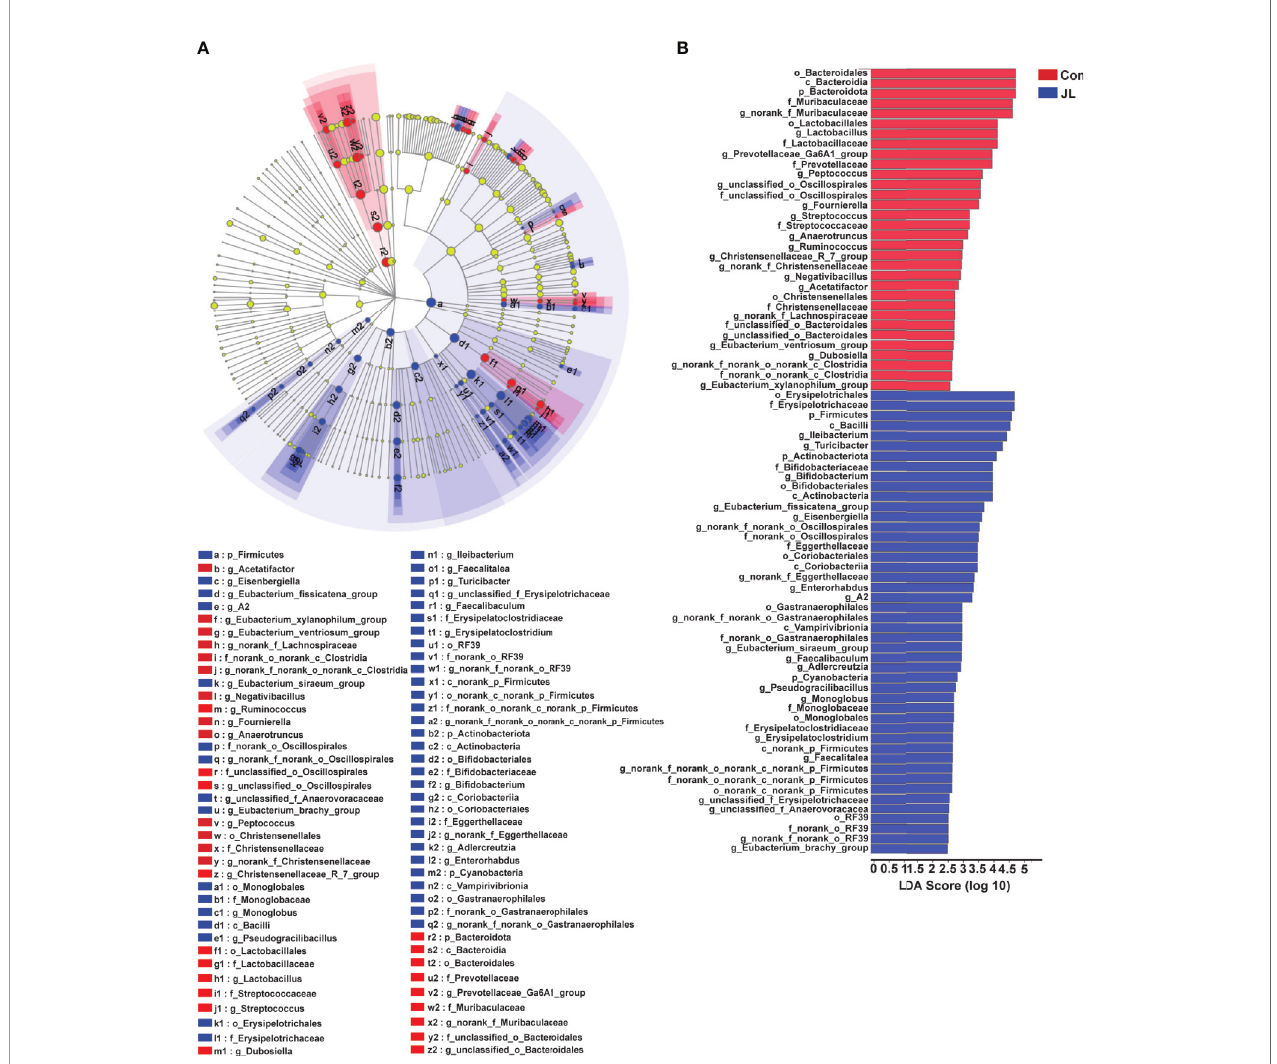
FIGURE 3 | LEfSe analysis of colonic microbiota in Con and JL groups. (A) Cladogram indicating the enriched taxa of colonic microbiome in Con (n = 6) and JL (n = 5) groups. The central point represents the root of the tree (Bacteria), and each ring represents the next lower taxonomic level (phylum to genus: p, phylum; c, class; o, order; f, family; g, genus). The diameter of each circle represents the relative abundance of the taxon. The different taxon was assessed by non-parametric factorial Kruskal-Wallis (KW) sum-rank test. (B) Taxa with a different abundance in the colonic microbiota between Con and JL groups are indicated. A cut ‐ off value ≥ 2.0 was used for the linear discriminant analysis